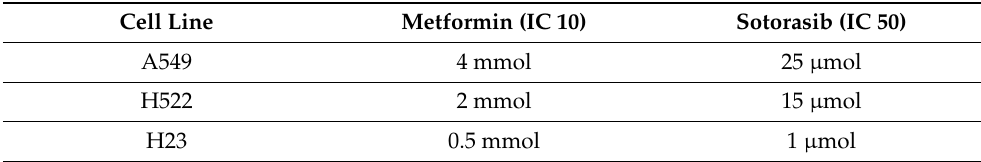
Table 1. Metformin and sotorasib work doses for each cell line. Cell